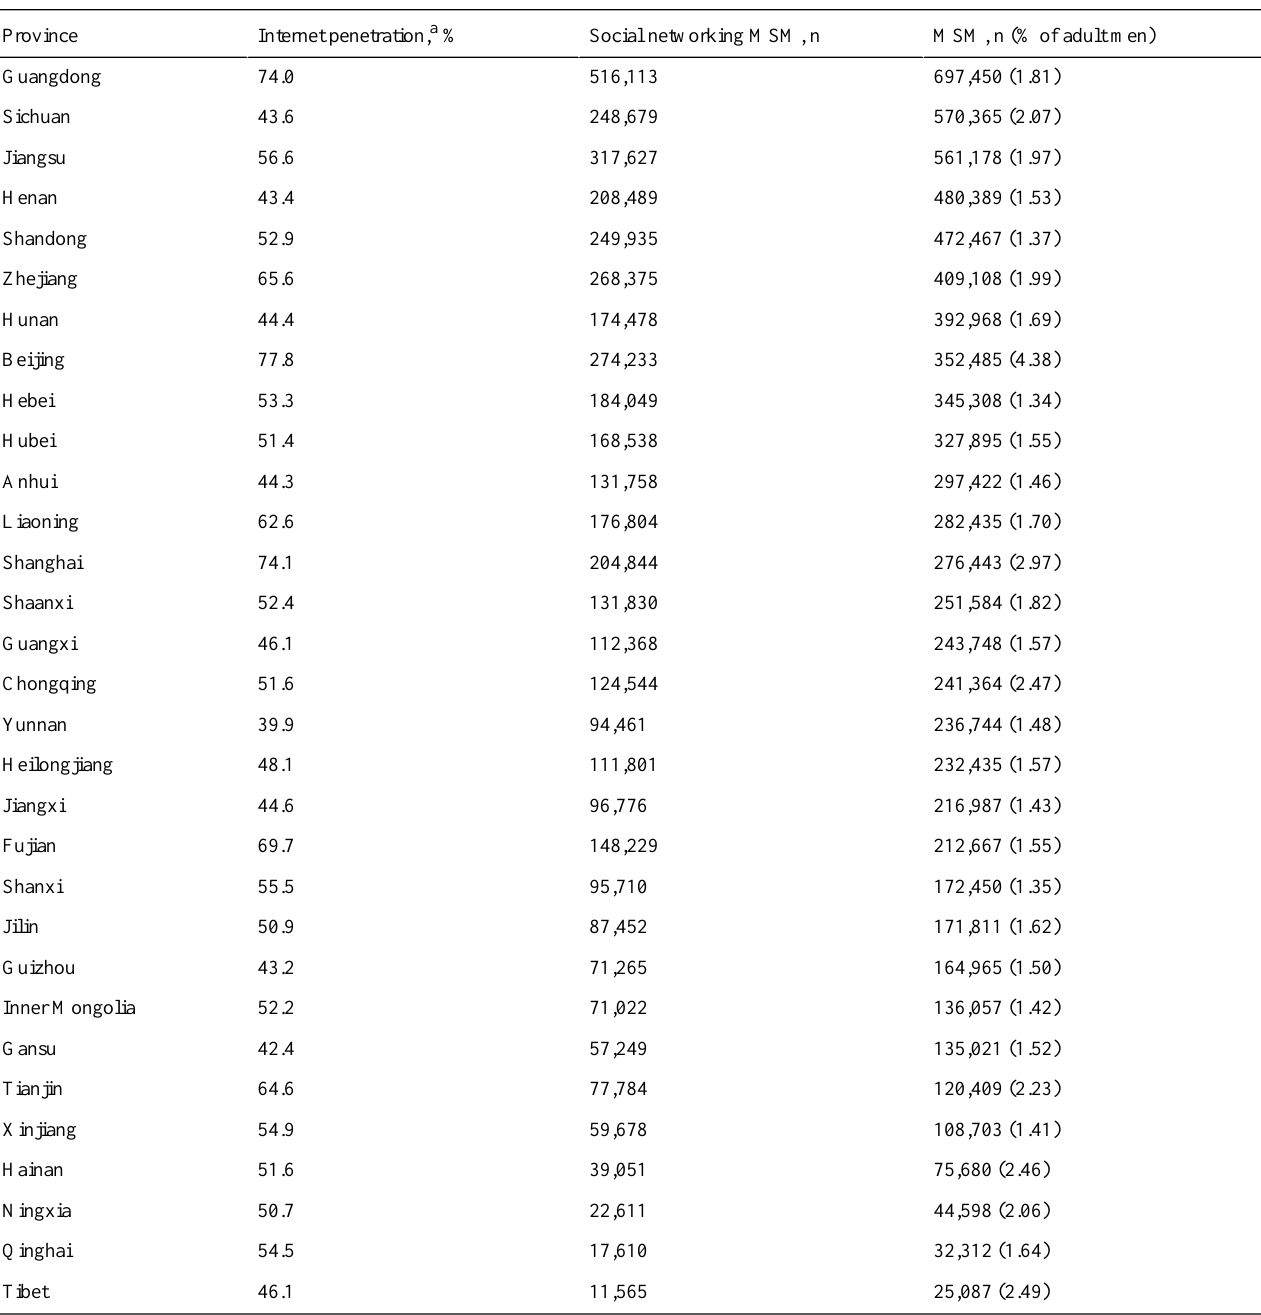
Table 1. Estimated provincial numbers and proportions of men who have sex with men (MSM) among adult men in mainland